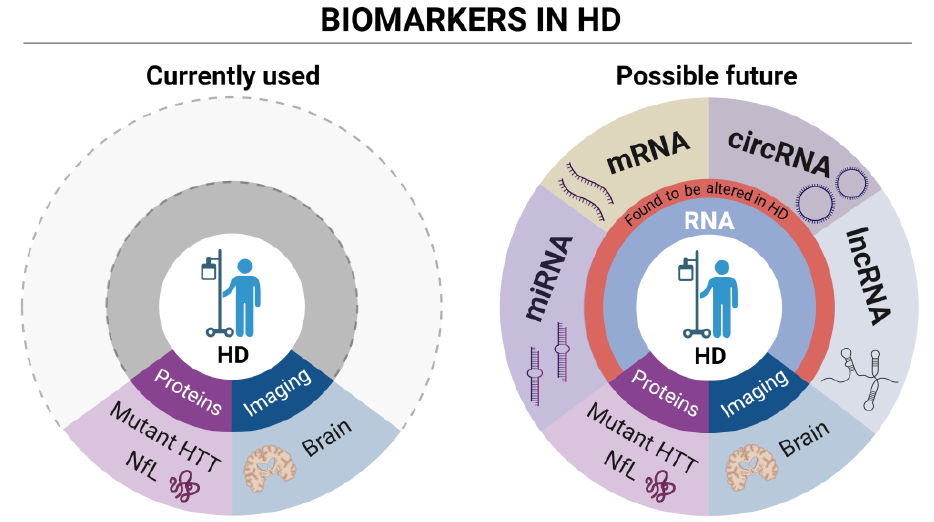
Figure 2. Currently used and possible future RNA biomarkers in HD. The cartoon on the left schematically describes the currently used wet (mutant HTT and NfL) protein biomarkers and imaging analysis in HD. The cartoon on the right